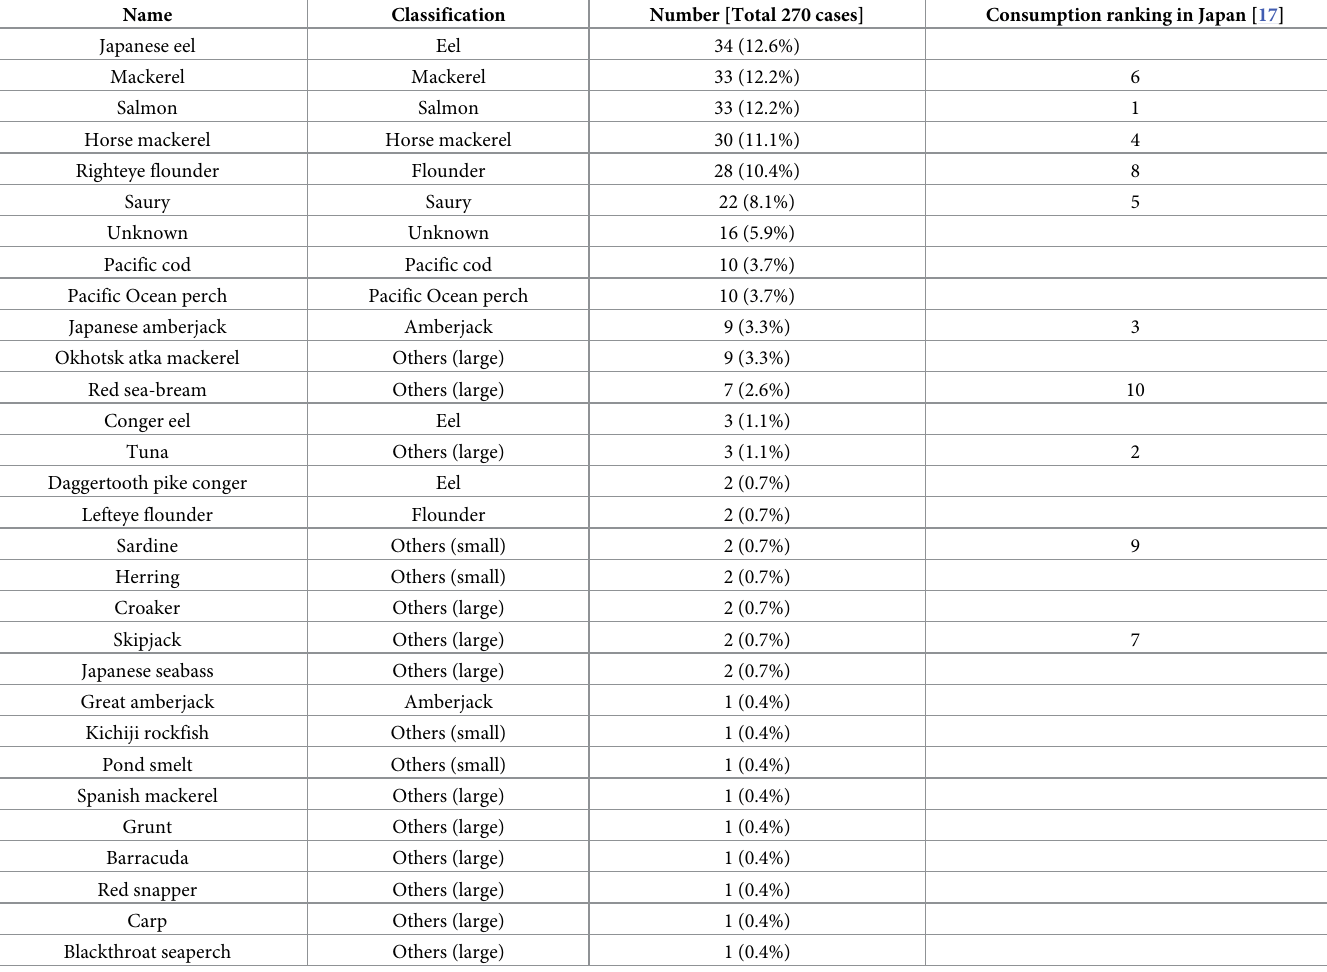
Table 2. The number of fish-bone foreign body cases and the ranking of household fresh fish consumption (weight/household/year in 2017–2019) in Japan (Statis- tics Bureau